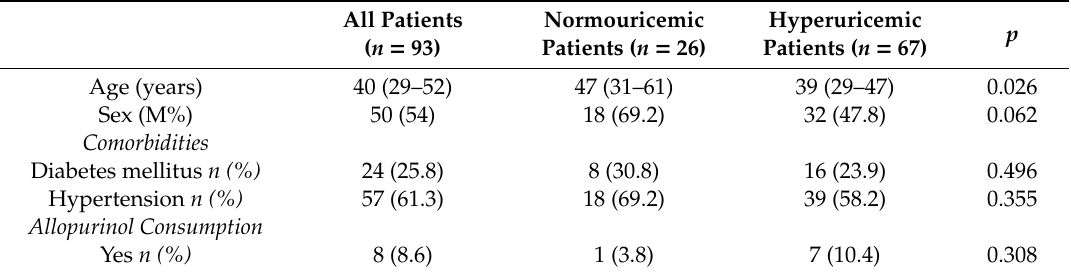
Table 1. General characteristics in normo and hyperuricemic patients on